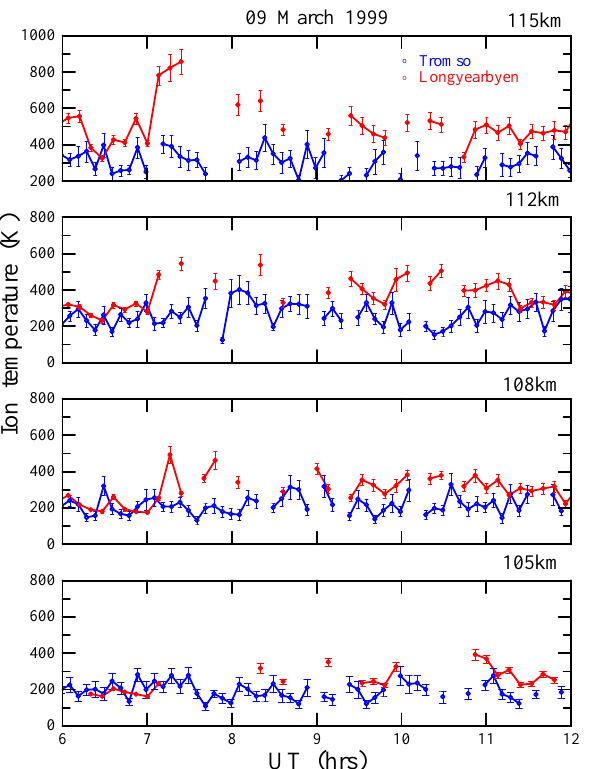
Fig. 7. Same as Fig. 6 except for 9 March 1999.